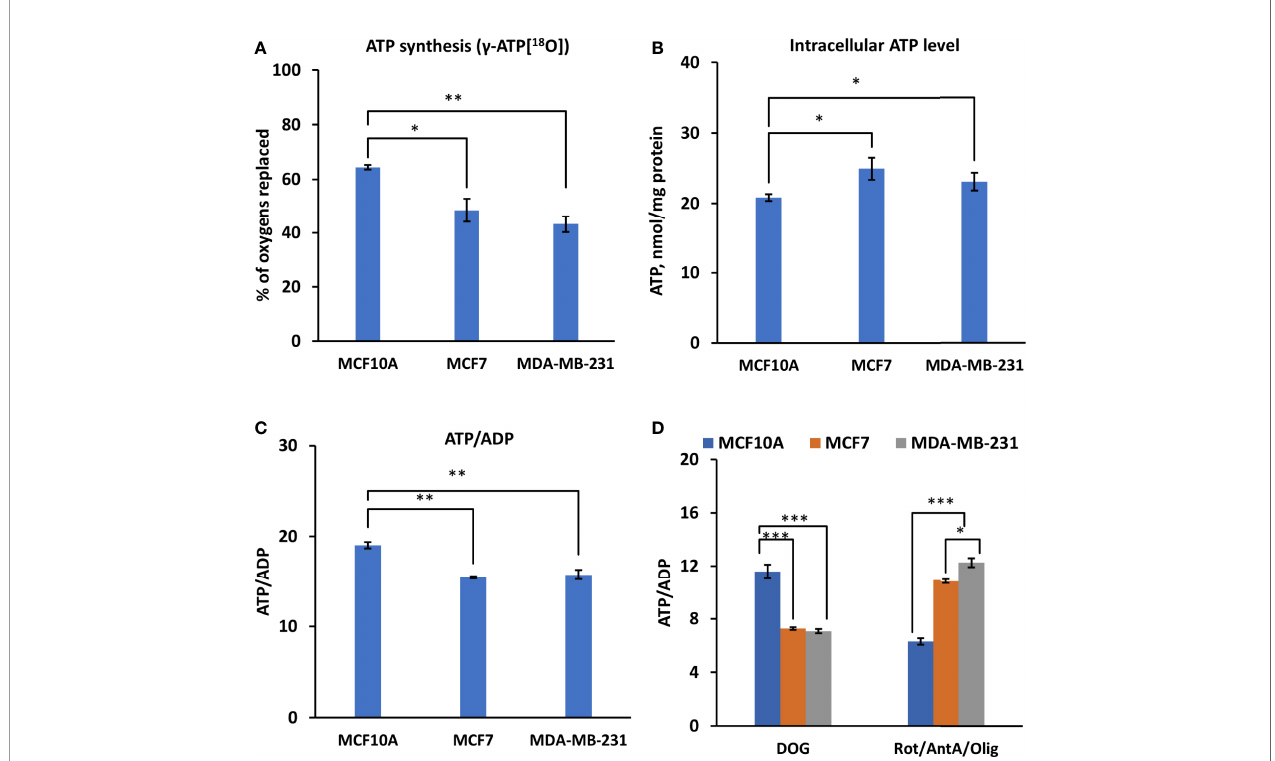
FIGURE 2 | Assessment of g -ATP[ 18 O] turnover and bioenergetic pro fi le in Luminal A, Triple-negative breast cancer cells, and control cells. Comparative analysis of intracellular (A) 18 O-metabolic labeling of g -ATP, re fl ecting ATP synthesis via OXPHOS. (B) Changes in ATP level and (C) ATP/ADP ratio between Luminal A (MCF7), Triple-negative (MDA-MB-231) breast cancer, and control cells (MCF10A). (D) Effect of glycolysis and OXPHOS inhibition on the intracellular ATP/ADP ratio. All data presented as mean ± SEM (ANOVA followed by Holm-Sidak test n=3-5). *, ** and *** indicate a statistically signi fi cant differences between the mean values; p < 0.05, p < 0.01 and p < 0.001, respectively. AntA – antimycin A, DOG – 2-deoxyglucose, Olig – oligomycin, Rot –